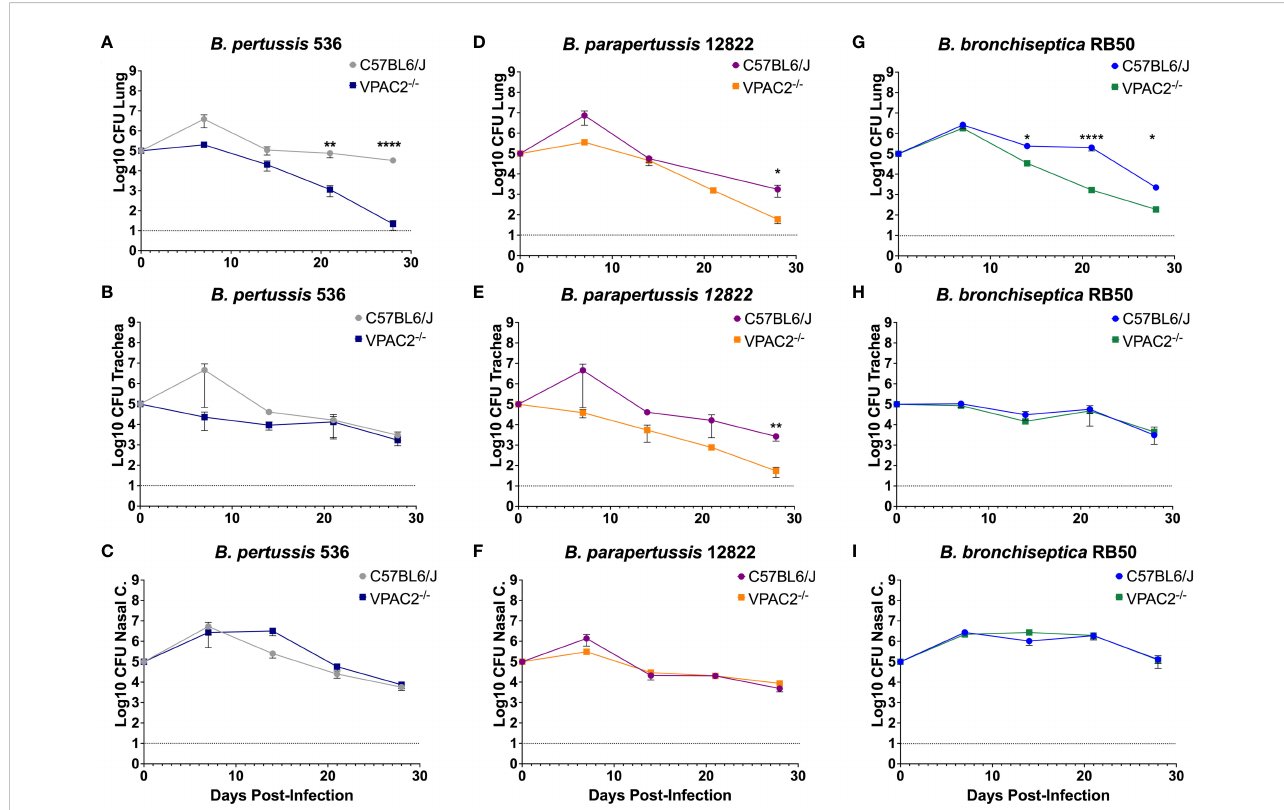
FIGURE 4 Functional VIP/VPAC2 axis promotes long-term persistent infection in the lungs. C57BL/6J and VPAC2 -/- mice, were intranasally challenged with different concentrations of B. pertussis BP536 (A-C) , B. parapertussis 12822 (D – F) , and B. bronchiseptica RB50 (G – I) , with mice strains indicated in each fi gure legend. At day 7 post-infection, we enumerated colonies from the nasal cavity (A, D, G) , trachea (B, E, H) , and lungs (C, F, I) . Inoculations were done in parallel in the two different mice strains and critical dosages were repeated at least in three independent experiments. Each point represents mean ± SEM (n = 5-20 mice per condition). Two-way ANOVA analysis was performed to evaluate statistical differences. *p ≤ 0.05, **p ≤ 0.01, ****p <